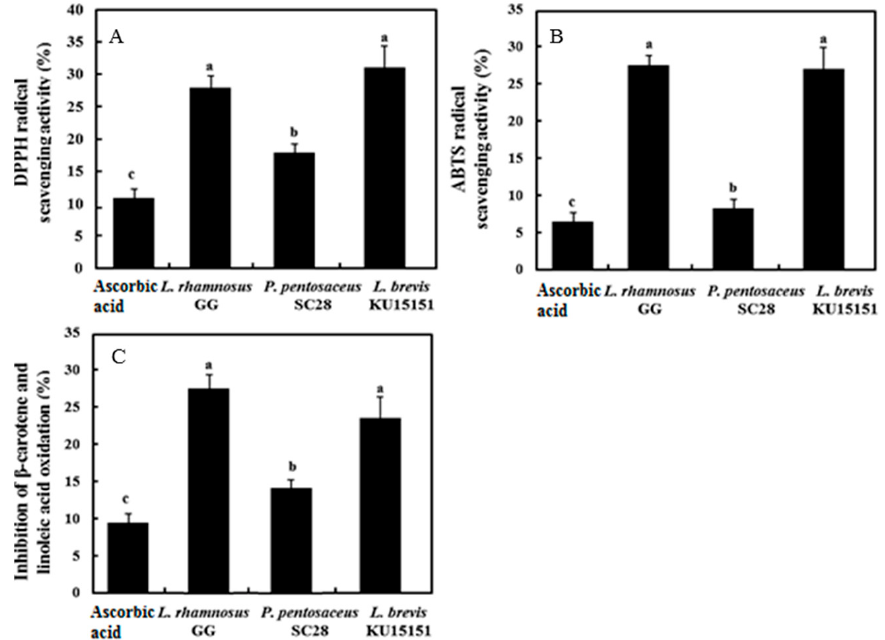
Figure 1. Antioxidant activities of LAB strains. ( A ) 2.2,-Diphenyl-1-picrylhydrazyl (DPPH) radical scavenging activity (%), ( B ) 2.2 ′ -azinobis(3-ethylbenzothiazoline-6-sulfonate) (ABTS) radical scavenging activity (%), and ( C ) inhibition of β -carotene and linoleic acid oxidation (%). Different letters on each bar indicate significant differences between strain samples ( p < 0.001).